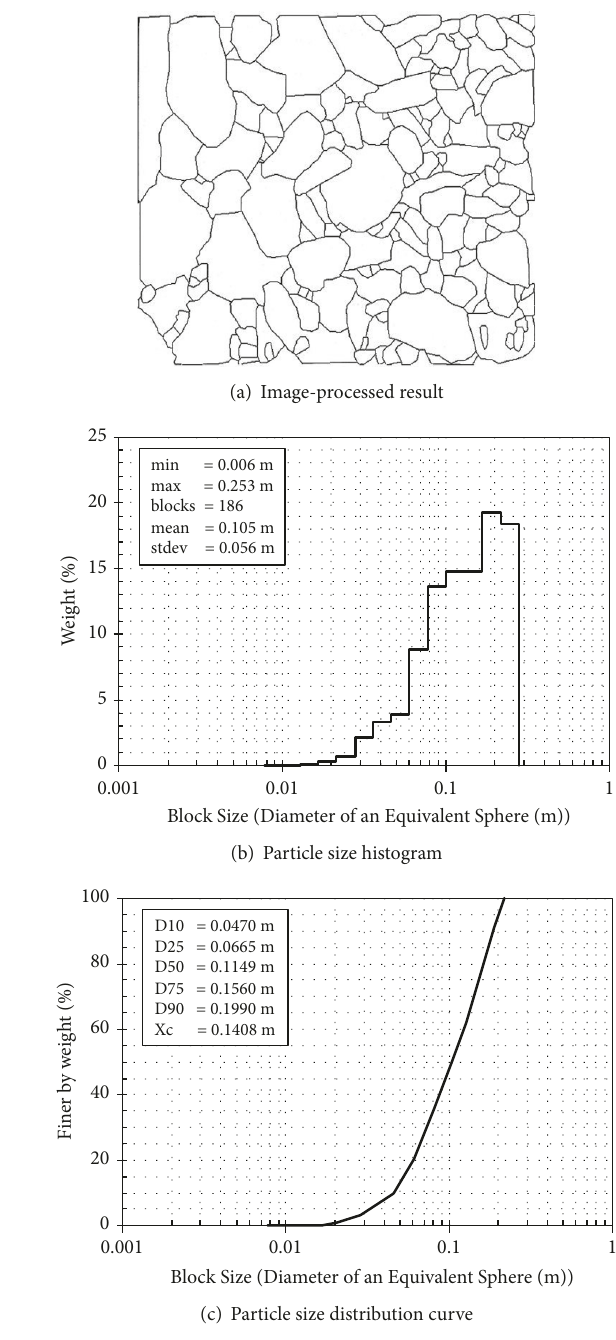
Figure 11: Particle size histogram and particle size distribution curve of blasted rock (WipFrag). (cylinder-cut, Test #4; Min. 0.7cm, Max. 27.5cm, Ave. 8.8cm).